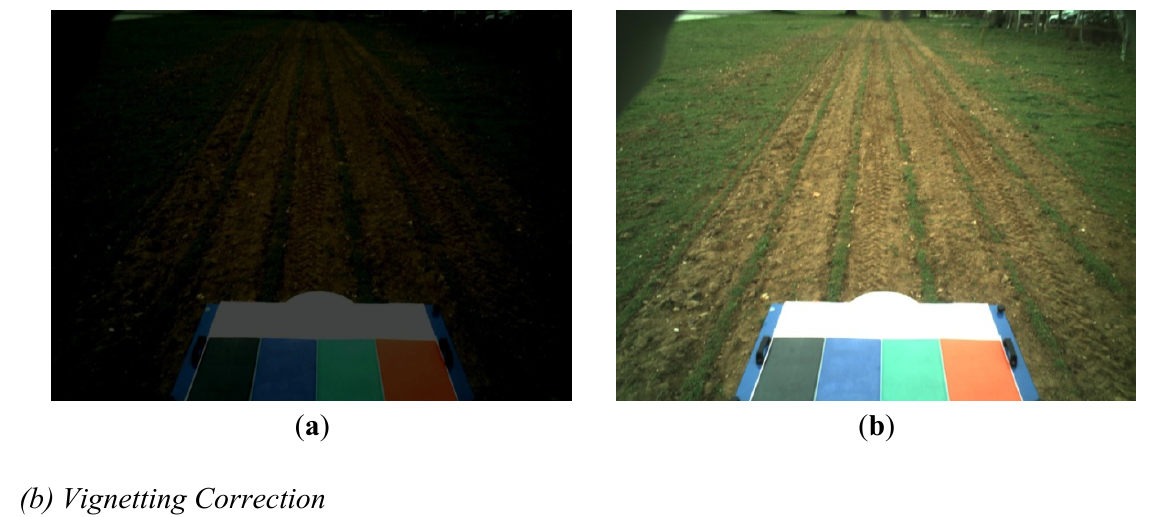
Figure 4. Images captured from the same scene with two different exposure